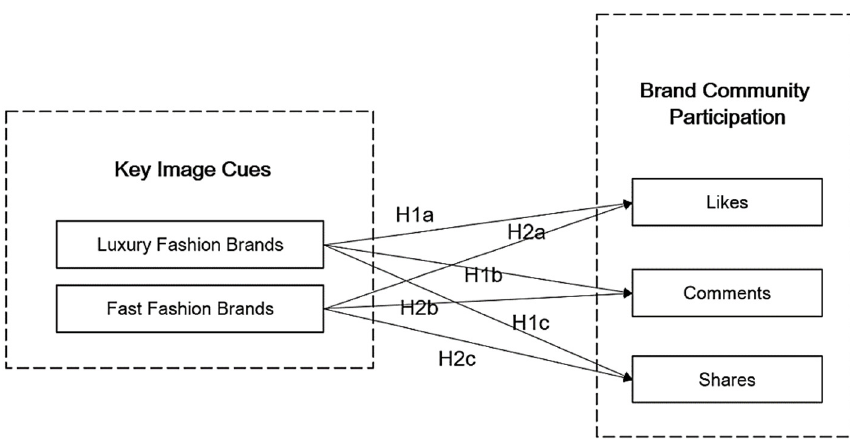
Figure 1. Extended research model.